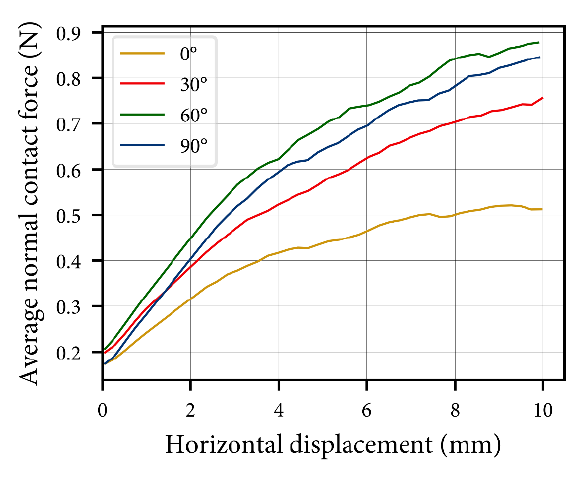
Figure 12. Average normal contact forces around fibers.